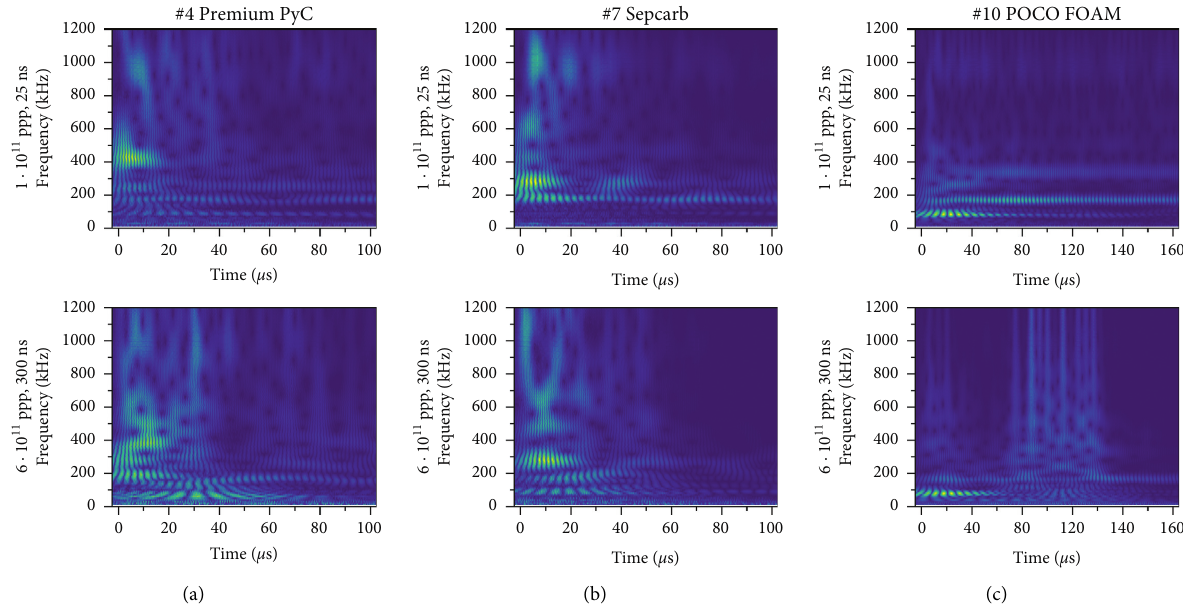
Figure 16: Continuous wavelet transformation of the radial surface velocity presented in Figure 14. (a–c) Compares two different carbon- fiber reinforced graphite composite and graphitic foam: #4 SGL Premium PyC (a), #7 ArianeGroup Sepcarb (b), and #3 POCO FOAM (c) at 1 × 10 11 ppp (top) and 6 × 10 11 ppp